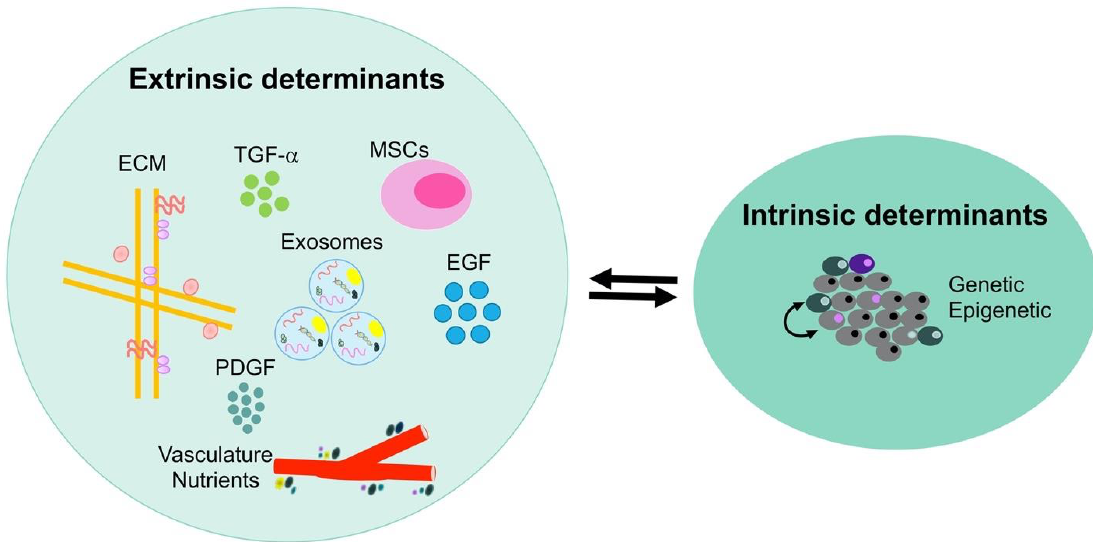
Figure 2. Intrinsic and extrinsic determinants that contribute to cancer cell heterogeneity. The heterogeneity arises from cell intrinsic phenotype (genetics, epigenetics, and cell origin), cell extrinsic determinants (extracellular matrix, vasculature, nutrients, MSCs, exosomes, TGF- α , EGF, and PDGF). Adapted from [4].